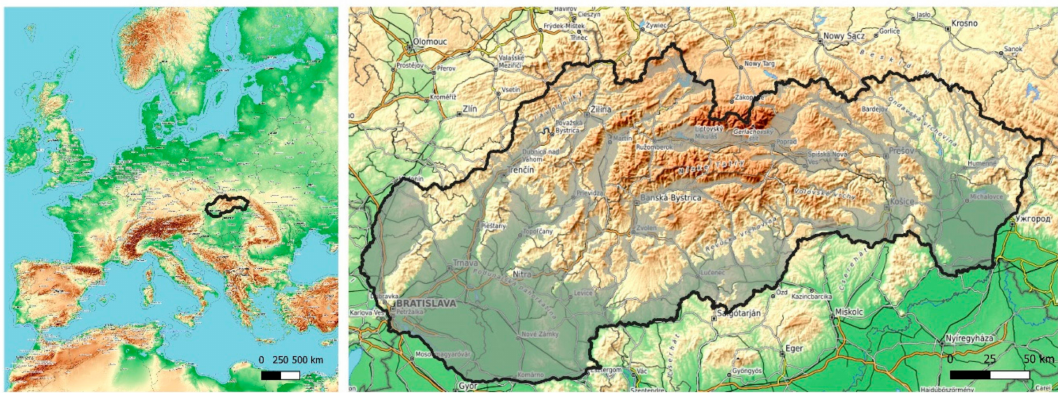
Figure 1. The study area of Slovakia. The grey color covers the area considered as being lowlands and basins. Source: OpenTopoMap (https: // opentopomap.org);